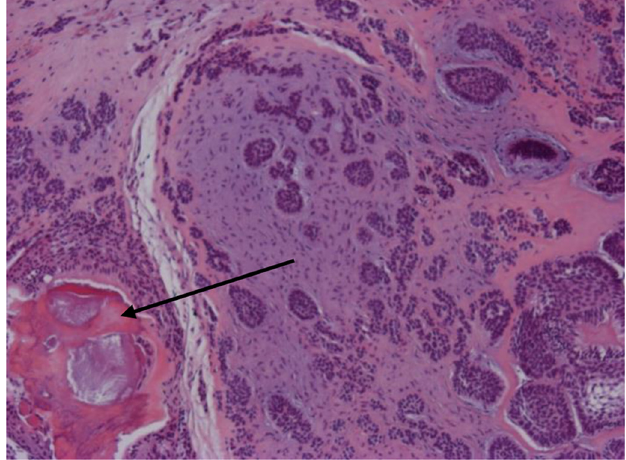
Fig. 6. Histological section. G (cid:1) 100 : Ameloblastic fi bro-odontoma. G (cid:1) 100. Orange mineralized area (black